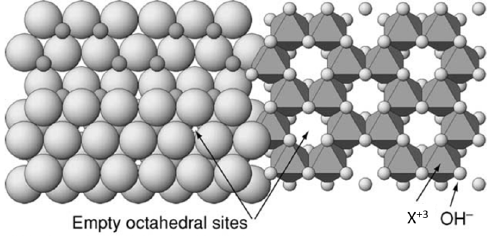
Figure 3. The representation of the octahedral sheet with dioctahedral arrangement in the sphere- packing ( left ) and polyhedral ( right ) model. Adapted from [21].